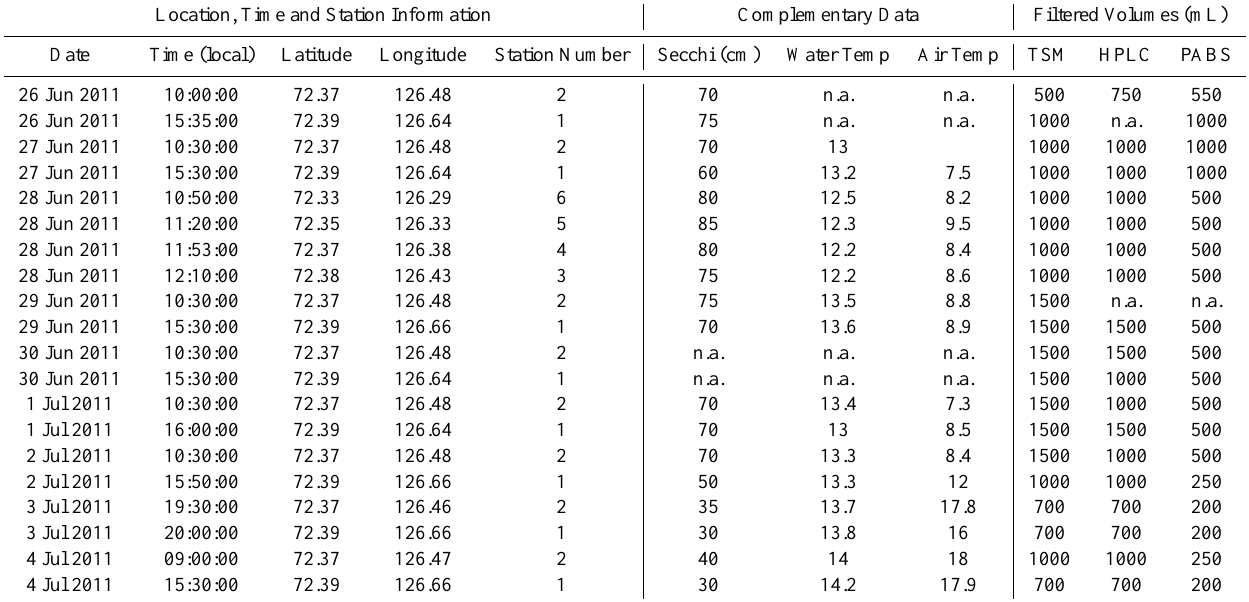
Table 2. Sampling protocol, complementary data, and filtered volume of the collected samples. (Station locations can be found in Fig. 1). n.a.: not